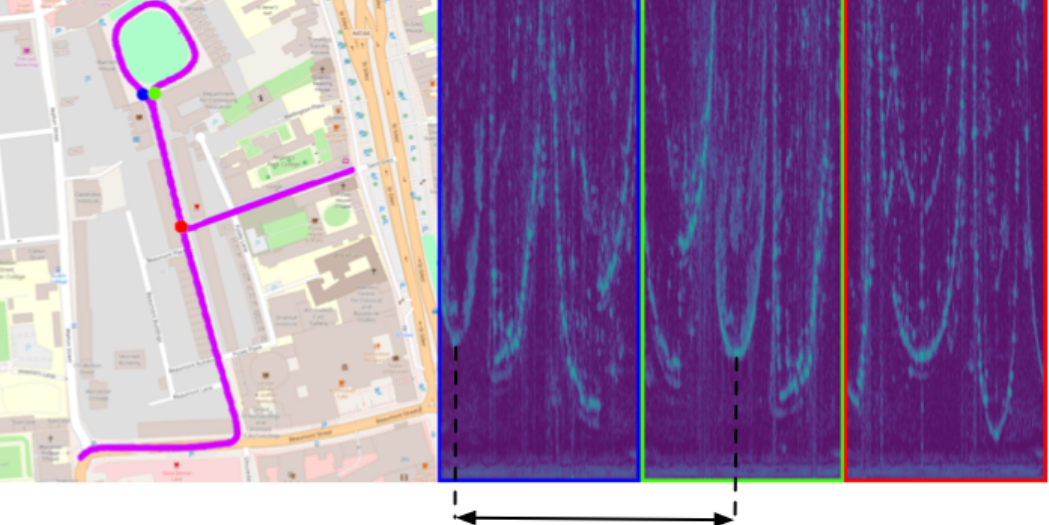
Figure 1. Our two-step system relies on a radar place recognition (RPR) module and a downstream pose refinement module. Firstly, consider the RPR module. Given an online query radar scan (blue dot on map and blue-framed radar image), the aim is to retrieve a correct match (green), disregarding the incorrect, although similar, radar scan the map also represents (red) and despite the obvious rotational offset. Secondly, consider the pose refinement module. Here, the rotational offset should not be disregarded and must be recovered. The range-azimuth region marked as interesting between the blue and green scans (dashed lines) is separated (solid lines) by such a rotational offset (significant wrapping around the horizontal axis), as well as a small translational offset (some movement down the vertical axis). Here, the conflict between the requirement that the RPR module be robust to small rotational and translational viewpoint differences and the requirement that the pose refinement module be precise in the same considerations are shown in this paper to be compatible in a framework that ultimately leads to a system which is more precise than RPR alone and more expedient than pose refinement